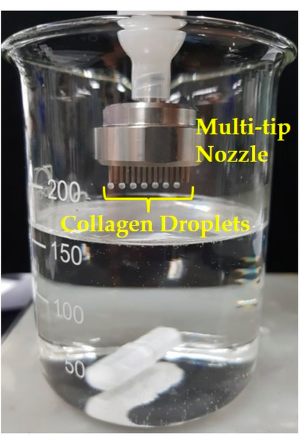
Figure 9. Optical image of collagen droplets formed at the tips of a multi-tip nozzle.